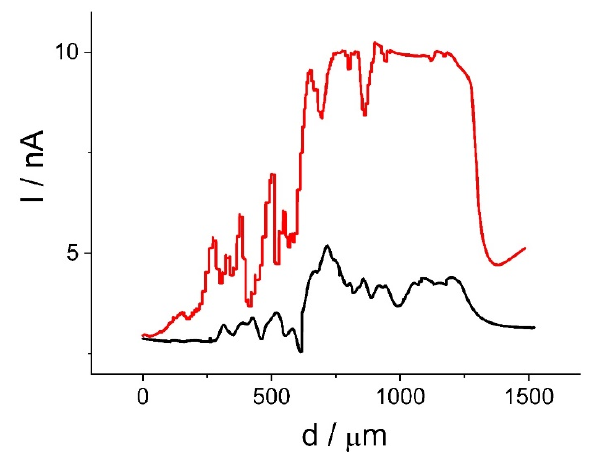
Figure 8. One-dimensional scans recorded in a 2 mM K 3 Fe(CN) 6 + 0.1 M KCl water solution with the microelectrode tip located at 10 µm above the oligo-( S )-BT 2 T 4 -Au. Microelectrode tip biased at 0.0 V substrate unbiased (black line) and biased at 1 V (red line).